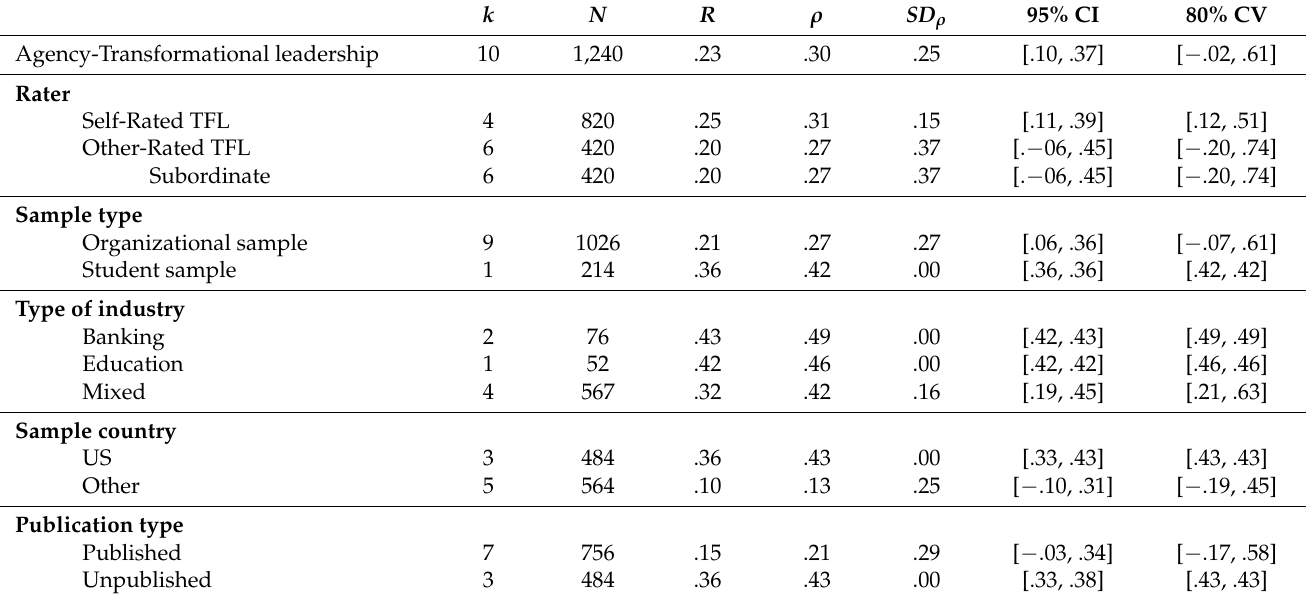
Table 4. Meta-analytic results for Agency and Transformational Leadership.